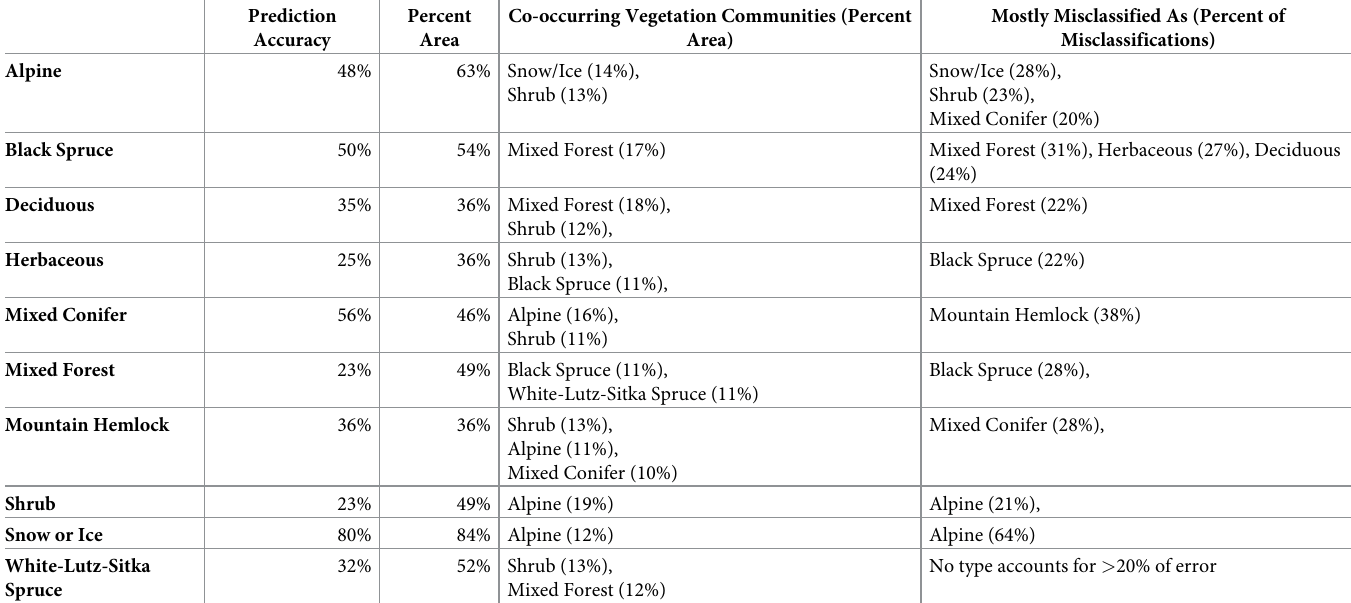
Table 3. Model prediction accuracy. Vegetation types on the Kenai Peninsula, Alaska, were classified at the 0.1 ha scale and rescaled to match the resolution of climate surface data for climate envelope modelling. Prediction accuracy for each vegetation type is based on the ability of the climate envelope model to predict the current vegeta- tion type of each climate cell. We assigned each climate cell the vegetation community with the largest area. Percent area is the average area of the 1-km climate cell occu- pied by the assigned vegetation type prior to rescaling the vegetation. We identify vegetation types as co-occurring when they occupy � 10% of the climate cell area. Co- occurring vegetation identifies vegetation types that occur within climate cells assigned to another type and the average percent of the 1-km cell occupied by the unassigned type. We identify the vegetation types that are most likely to be misclassified as another type by the climate envelope model as vegetation types that represent � 20% the misclassified cells.